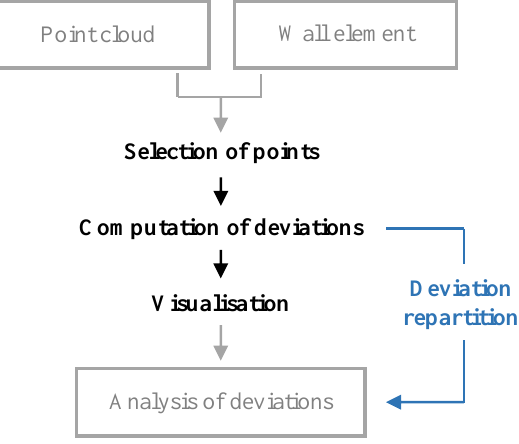
Figure 2: Overview of the developed plug-in The user is prompted to select a wall and a point cloud in the Revit environment either in a 2D or a 3D view. Points which are within a given distance from the two faces of the wall are selected. For those points, deviations between points and the wall are computed by projecting points on wall faces. Finally, the wall and the points — colorized according to the calculated distances — are displayed in a 3D view. Information about the repartition of deviations can help the user to analyse the result. The different steps are detailed